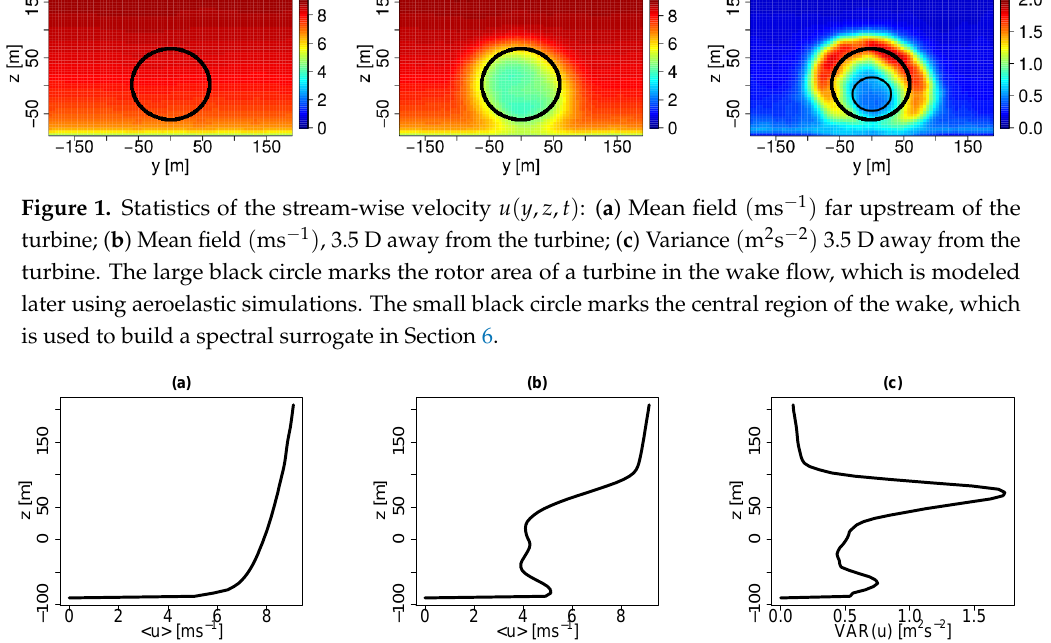
Figure 2. Different profiles at y = 0 m corresponding to the figures in Figure 1: ( a ) Mean field far upstream of the turbine; ( b ) Mean field 3.5 D away from the turbine; ( c ) Variance 3.5 D away from the turbine.